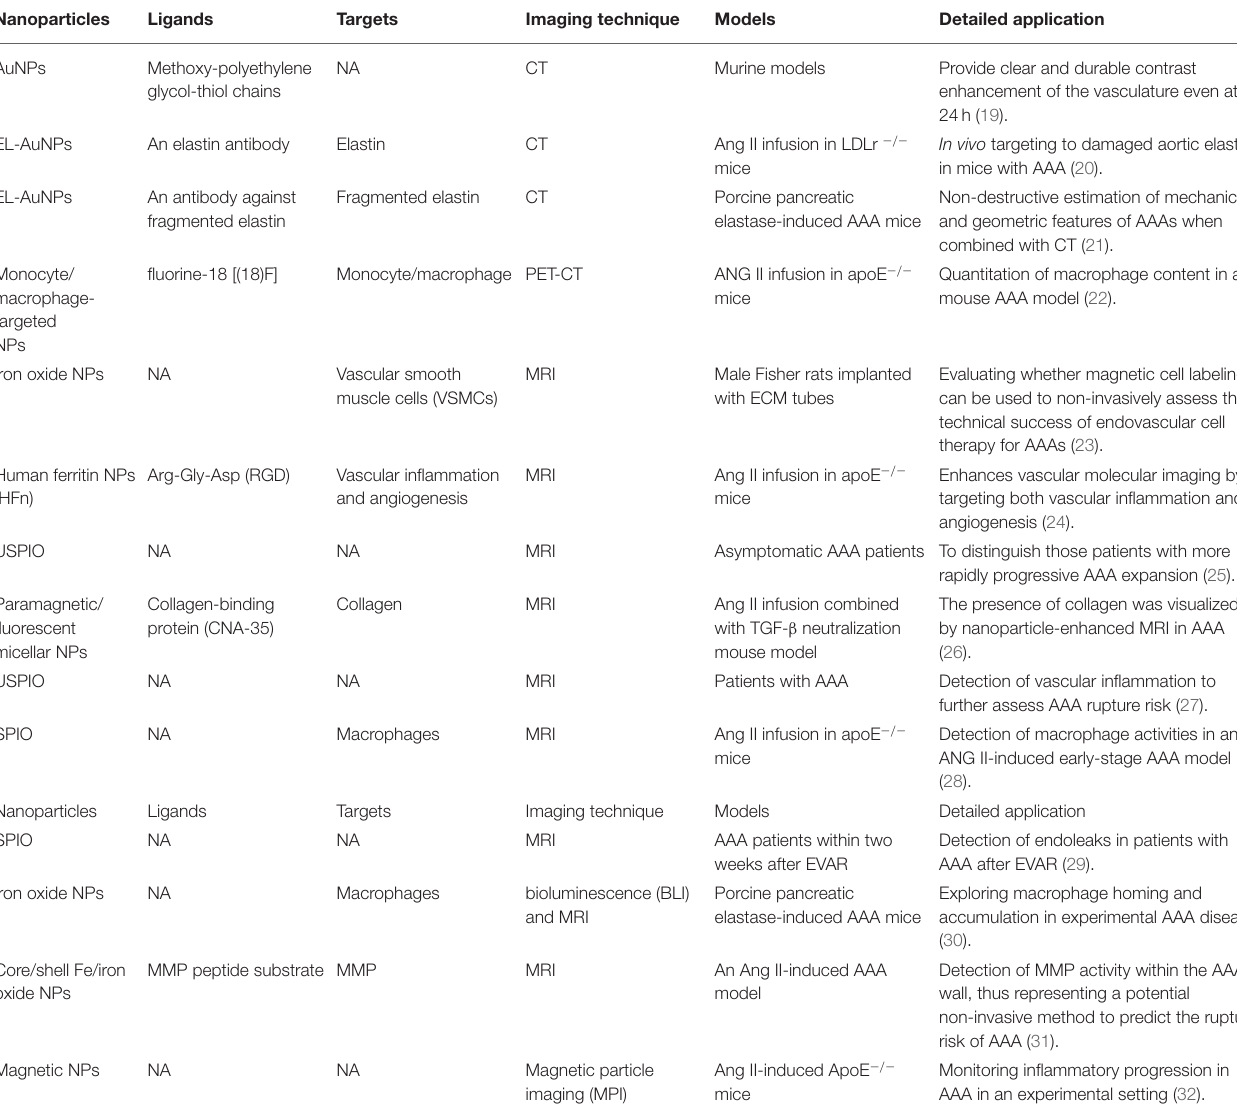
TABLE 1 | Nanoparticles in AAA